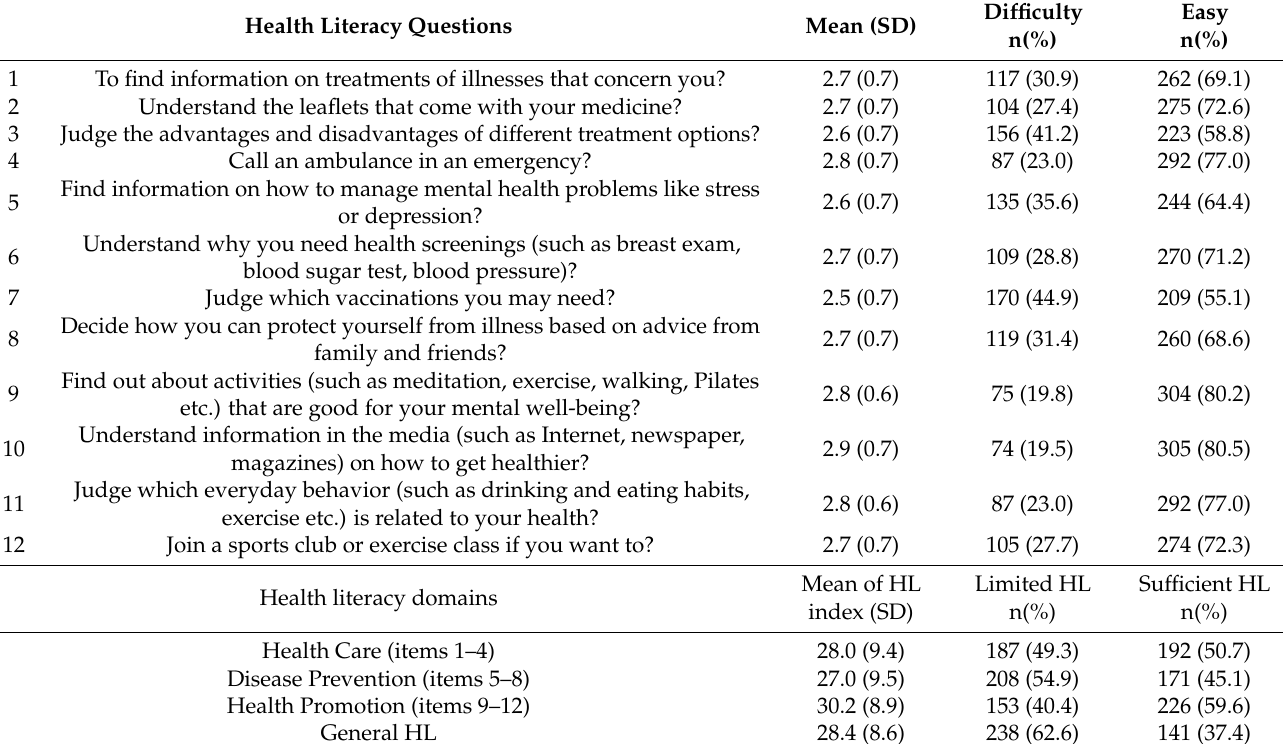
Table 2. Score of HLS-SF12 ( N = 379).